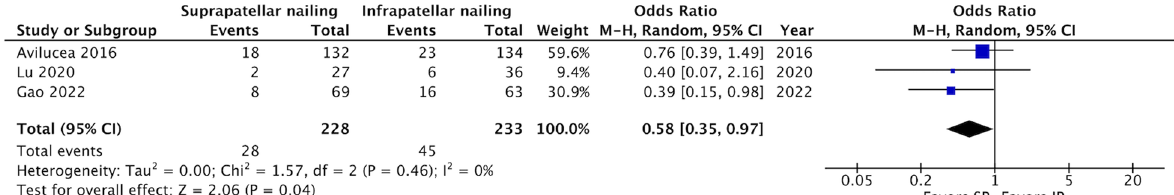
Fig. 7 Forest plot of the need for open reduction. The SP group had a lower risk for open reduction than the IP group (OR: 0.58; 95% CI 0.35 to 0.97; NNT: 16 (95% CI 10 to 233); P 0.04; I 2 0%). CI confidence interval, NNT number needed to treat, OR odds ratio = =